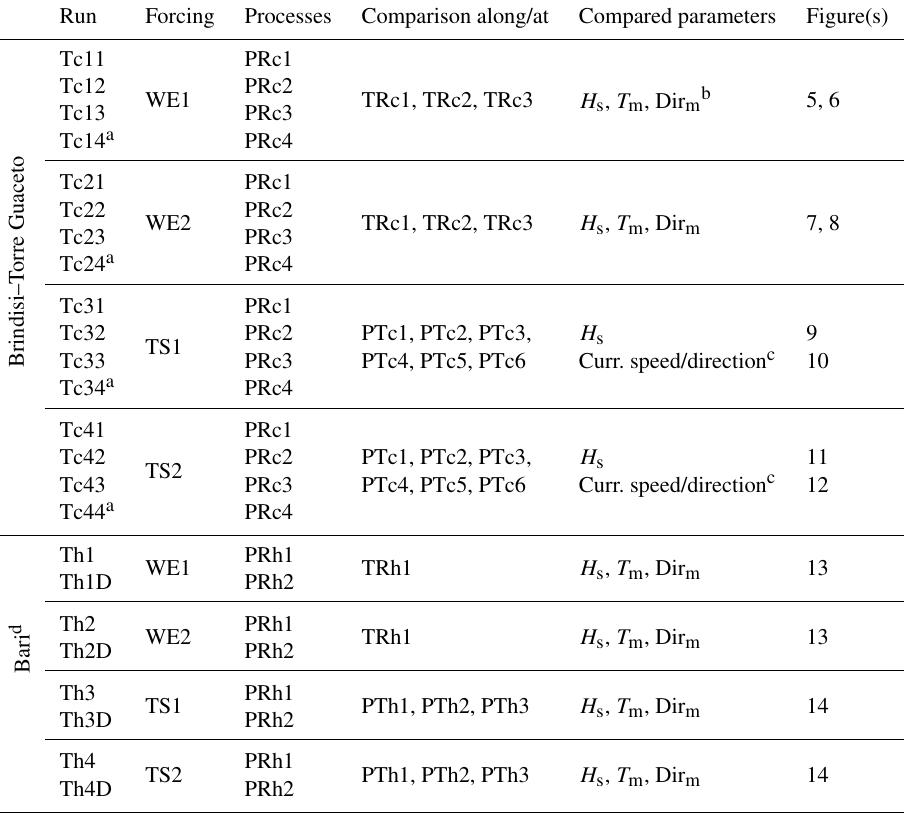
Table 1. Overview of TELEMAC and MIKE21 model runs. Run Forcing Processes